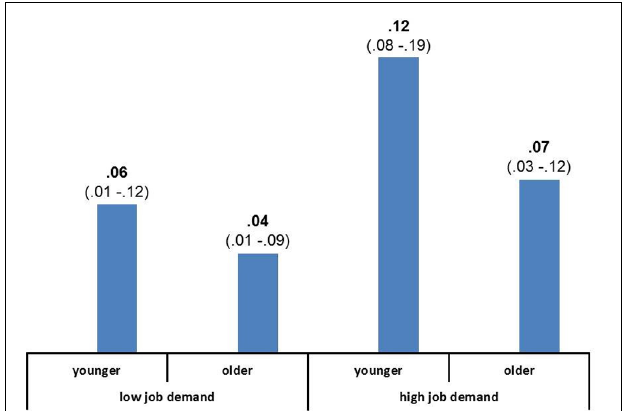
FIGURE 2 | Indirect effects of the full mediational moderated model. Confidence intervals of indirect effects based on 10,000 bias corrected bootstrap samples are given in